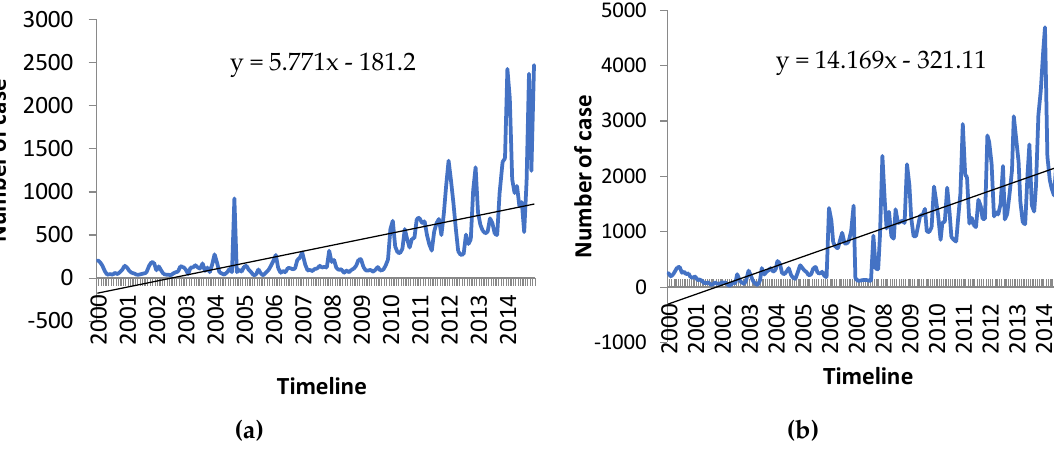
Figure 4. Observed trends of (a) diarrhea in Antsiranana and ( b ) ARI in Farafangana.